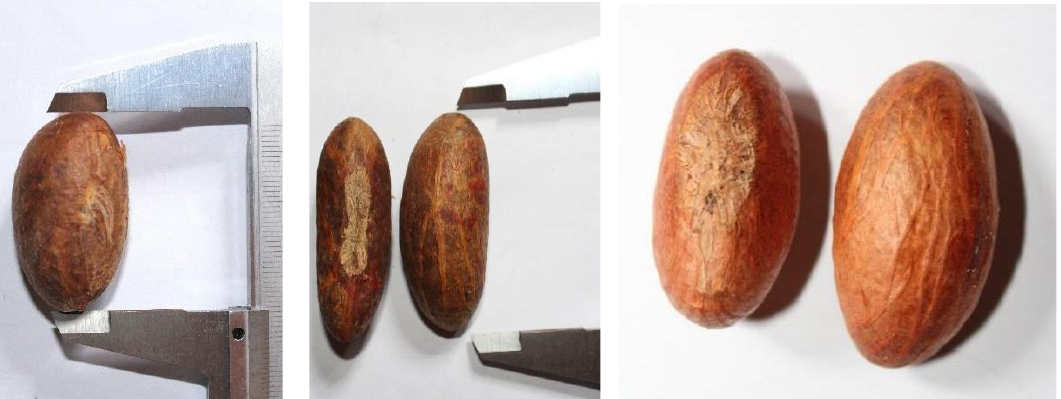
Figure 3. The most common shapes of G. kola seeds — oblong-elongated, ellipsoid and oblong (from left).